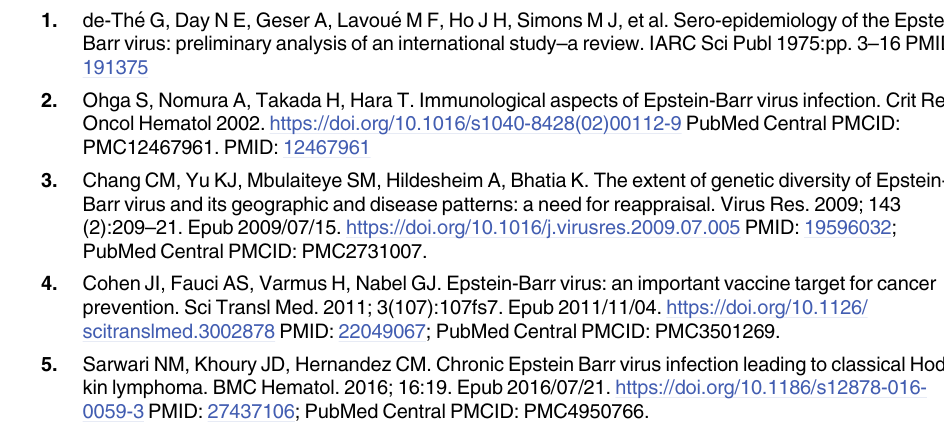
S1 Video. 2D visualization of an 18.5 micron confocal image stack playing through 50 sec- tions and demonstrating distribution of lamin B1 (Red), lamin A/C (Green), and DAPI labeled DNA (Blue). (MP4) S2 Video. 3D reconstruction of an 18.5 micron confocal image stack demonstrating overall morphology and distribution of lamin B1 (Red), lamin A/C (Green), and DAPI labeled DNA (Blue).